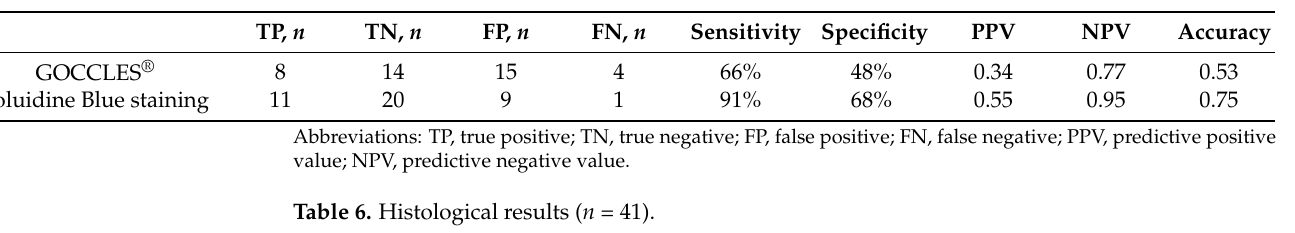
Table 5. Correlation of GOCCLES ® examination and Toluidine Blue staining with histopathological findings ( n = 41 lesions).